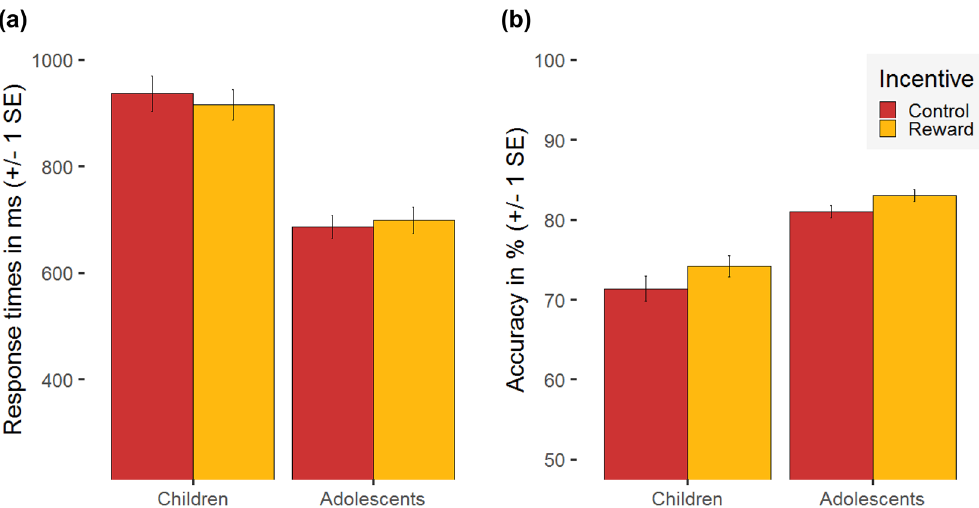
Figure 2. Behavioural performance: Mean and standard error (SE) for (a ) response times (RT) in milliseconds and ( b ) accuracy in percent, both separated for the two incentive conditions (reward vs. control) and the two age groups (children vs. adolescents).